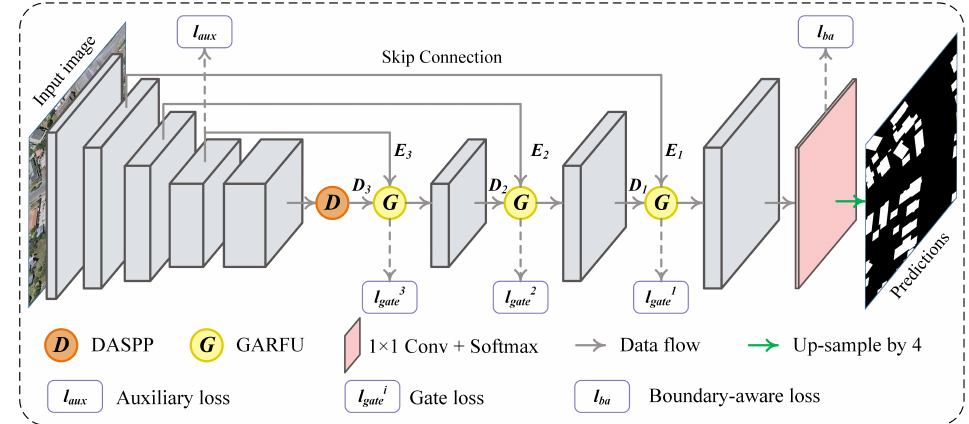
Figure 2. Overall structure of the proposed Boundary-Aware Refined Network